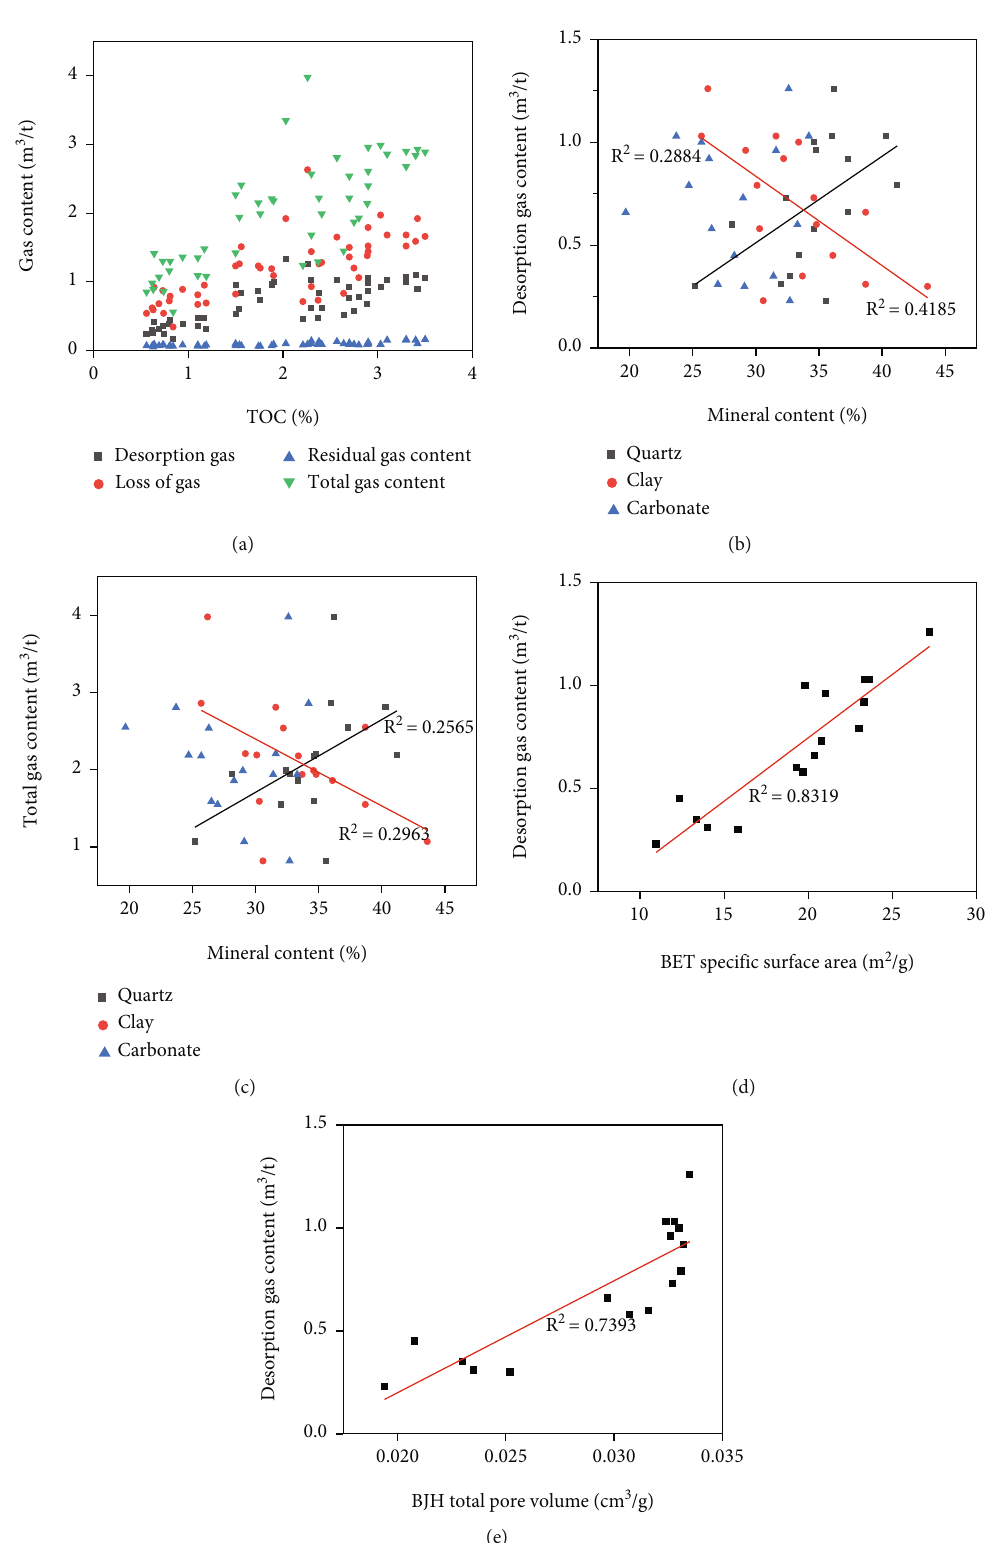
Figure 20: Relationships between in fl uencing factors of gas-bearing properties of shale